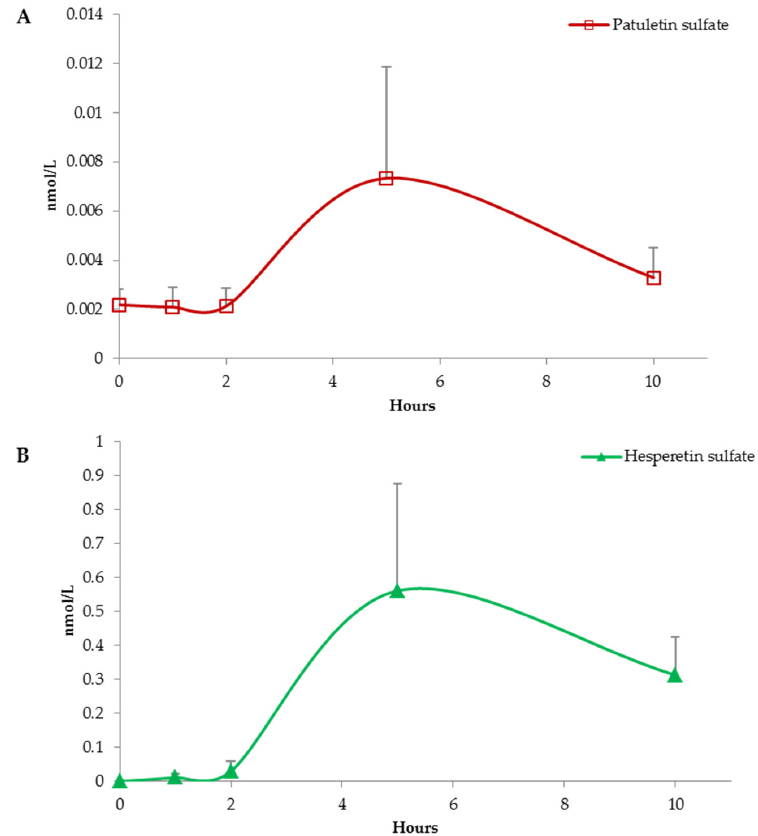
Figure 2. Absorption curves of patuletin sulfate in graph ( A ) and hesperetin sulfate in graph ( B ). Data are expressed as mean values and bars represent standard error of means (SEM).